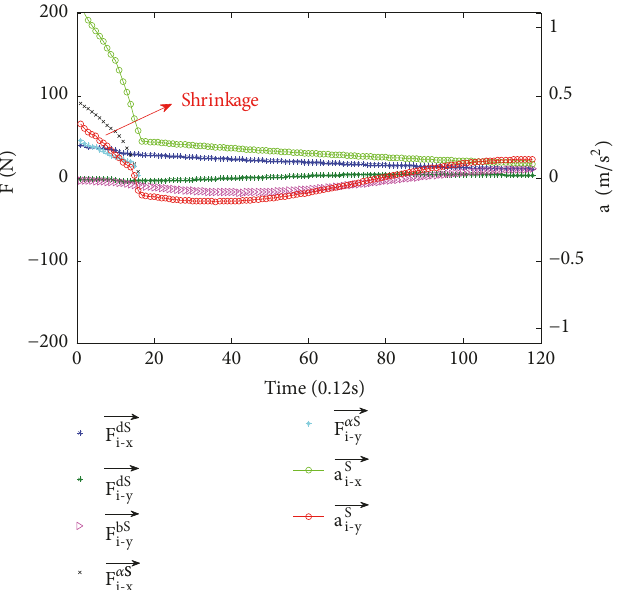
Figure 21: Force and acceleration in the